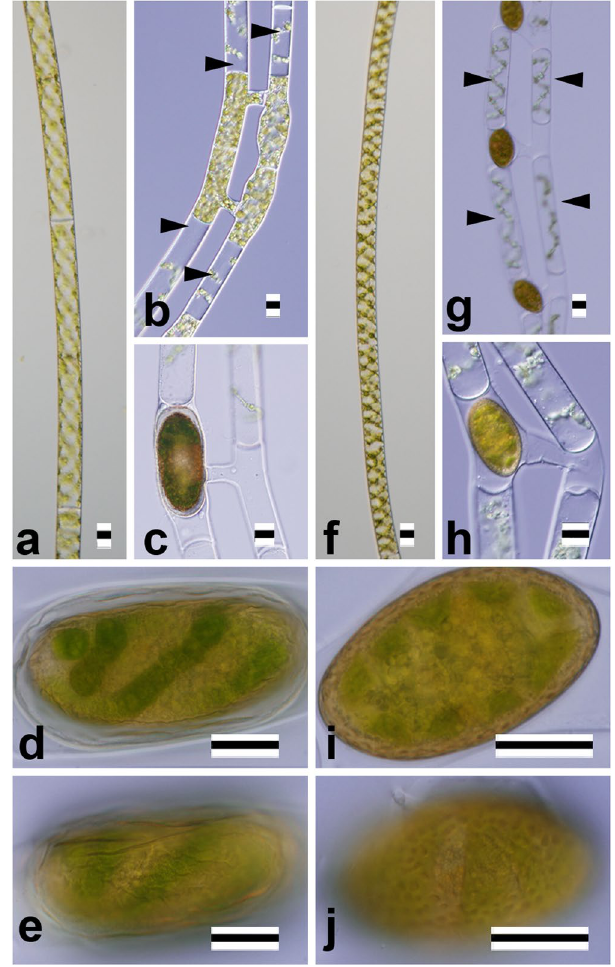
Figure 4. Nomarski interference micrographs of two Spirogyra species assignable to “ Temnogyra ” (Table 1, Supplementary Fig. S1). Scale bars = 20 μ m. ( a – e ) S . corrugata A2F (JPS002). ( f – j ) S . punctata Tpx8 (JPS013). ( a , f ) Vegetative cells. ( b , c , g , h ) Formation of zygospores showing sterile cells adjoining gametangia (arrowheads in b , g ). ( d , i ) Optical section of zygospore. ( e , j ) Surface view of